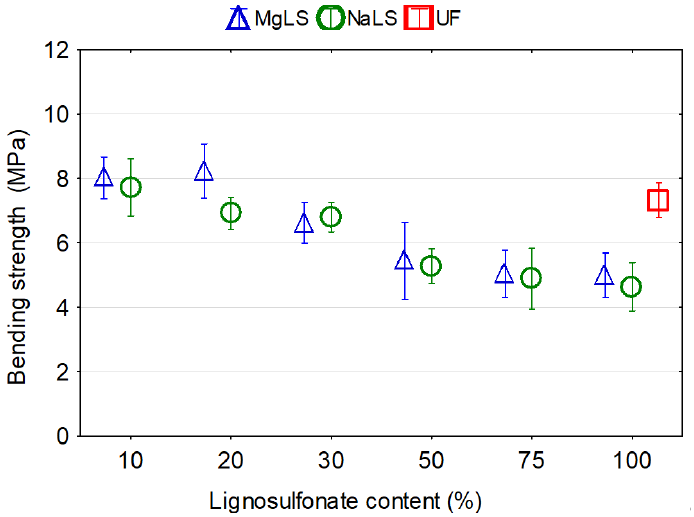
Materials 2021 , 14 , x FOR PEER REVIEW 15 of 22 Figure 8. Bending strength (MOR) of boards made with lignosulfonated-urea-formaldehyde adhesive.